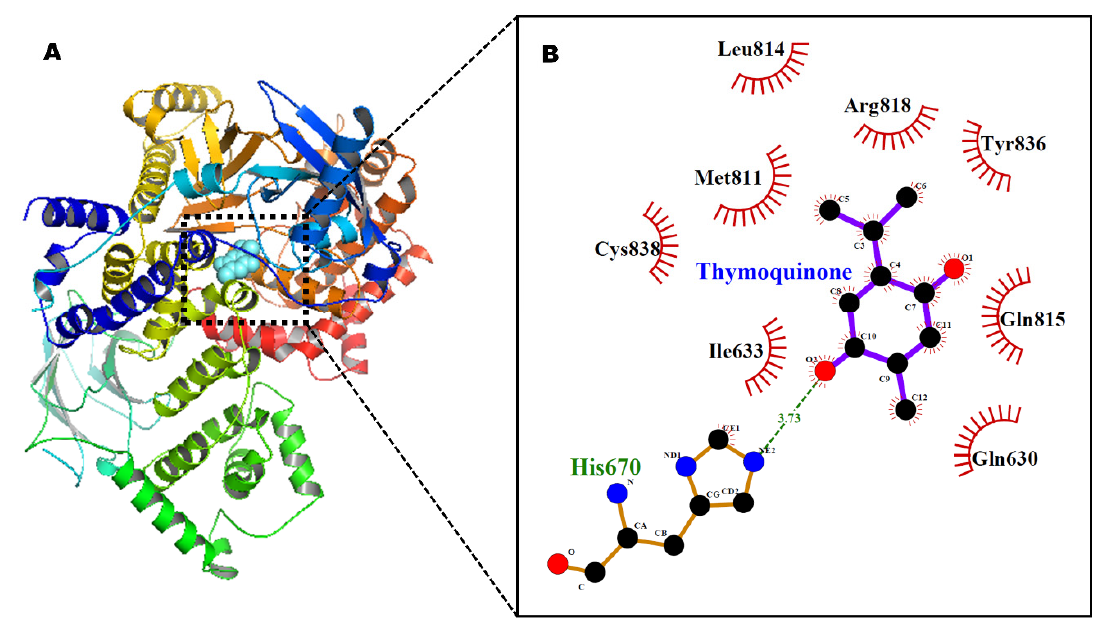
Figure 3. Docked TQ in the binding pocket of phosphatidylinositol-3 kinase alpha, shown in ribbon style ( A ). Ligplot diagram ( B ) showing intermolecular interactions. Hydrogen bond interaction is shown as a broken green line.